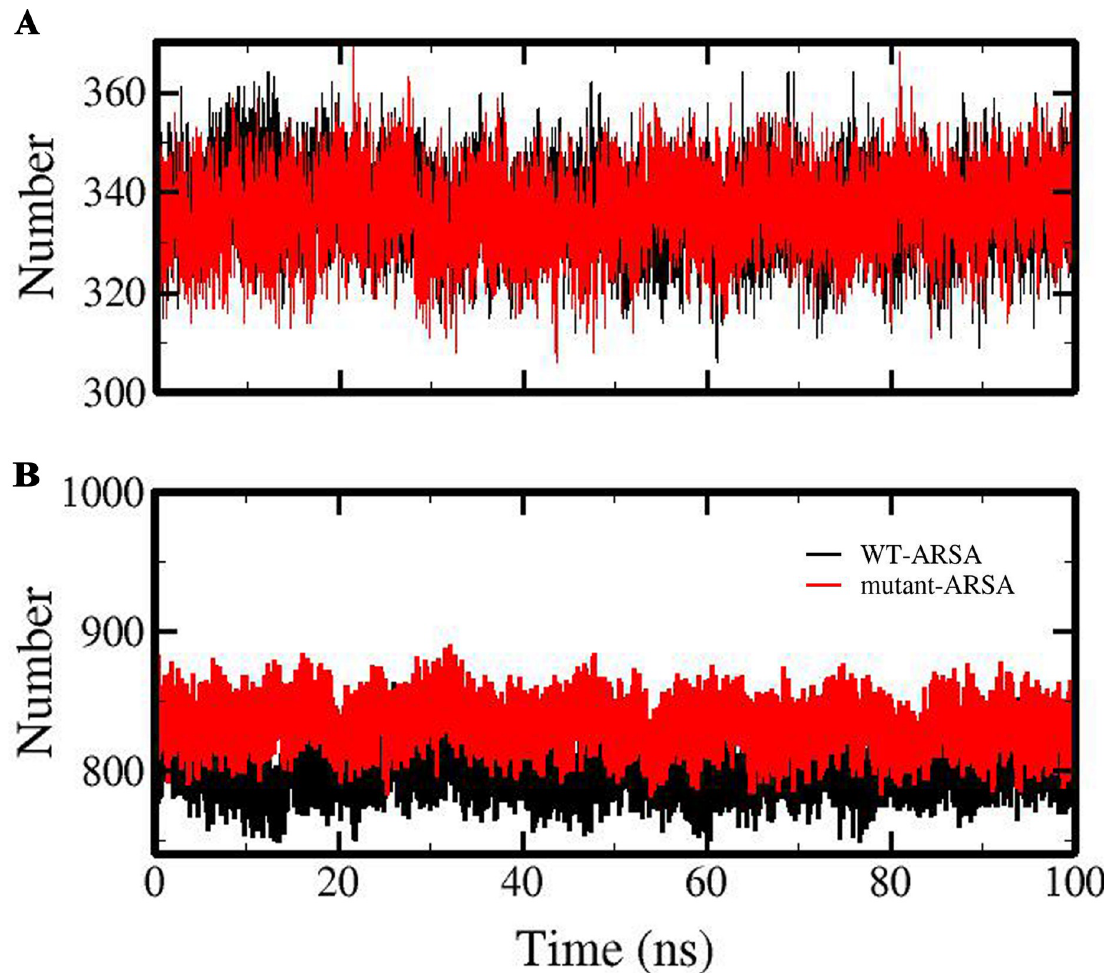
Fig 5. The pattern of hydrogen bonds during 100 ns MD simulation for ARSA proteins. (A) Intramolecular and (B) protein-solvent hydrogen bonds of WT-ARSA and